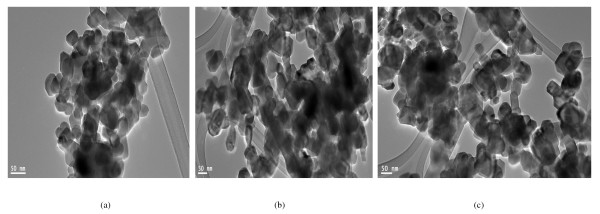
TEM micrographs of (a) 0.0, (b) 0.5, and (c) 0.1 compositions of Ni0.7-xZnxCu0.3Fe2O4 ferrite nanoparticles.